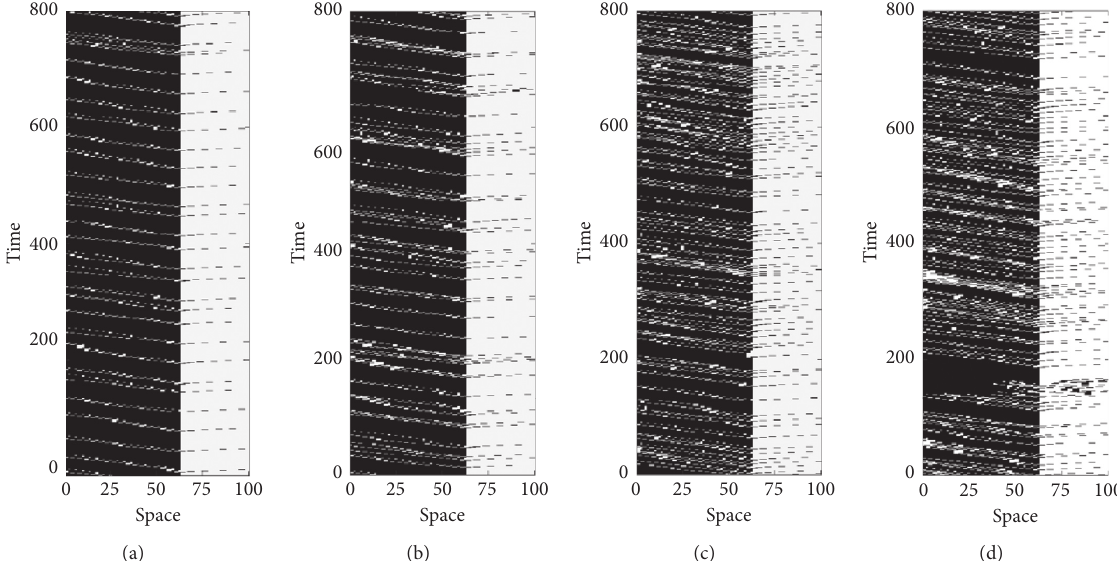
Figure 10: Space-time diagrams of saturation flow vehicles under different driving ( α v � 0.5, α b � 0.5). (a) β v